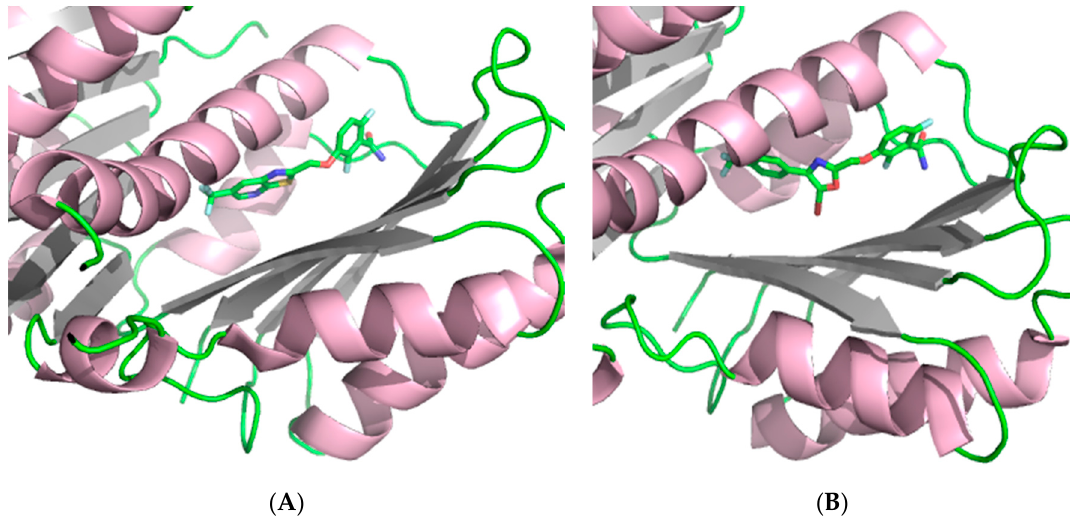
Figure 5. ( A ) Crystal structure of Sa FtsZ at 1.3 Å in complex with TXA707 ( 12 ) (PDB entry 5XDT) [41]. ( B ) Crystal structure of Sa FtsZ at 2 Å in complex with TXA6101 ( 13 ) (PDB entry 5XDU) [41].